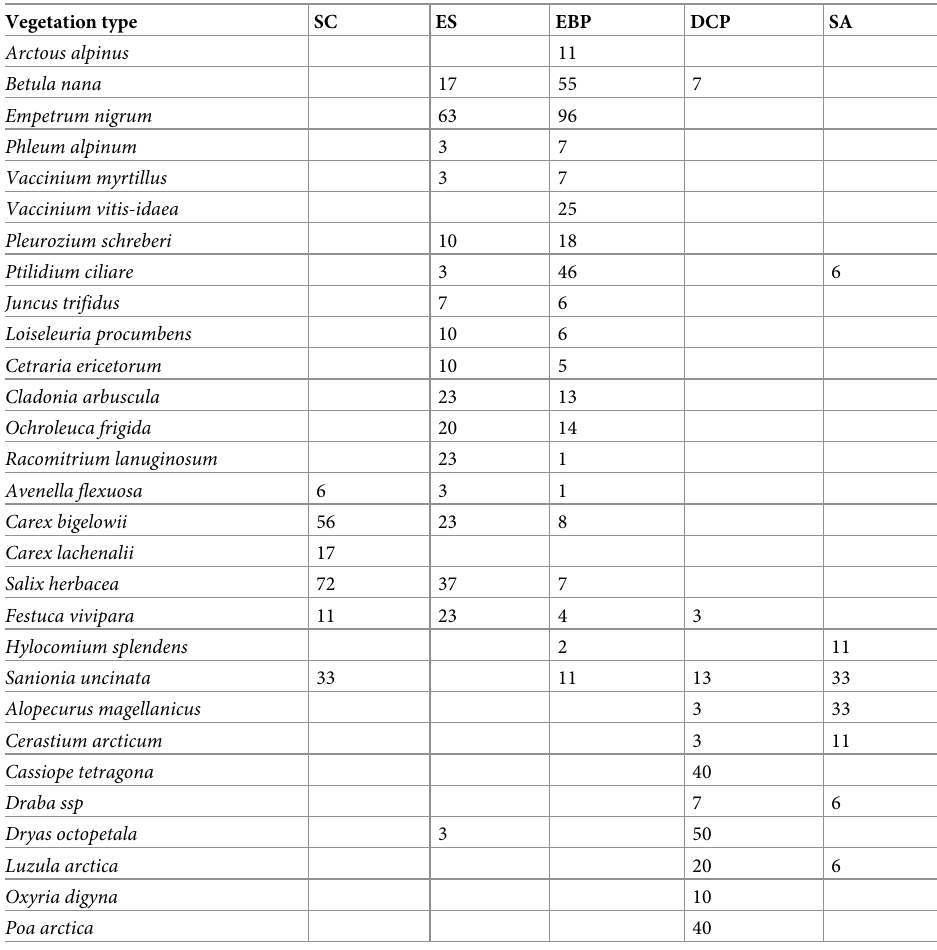
Table 2. Results of TWINSPAN